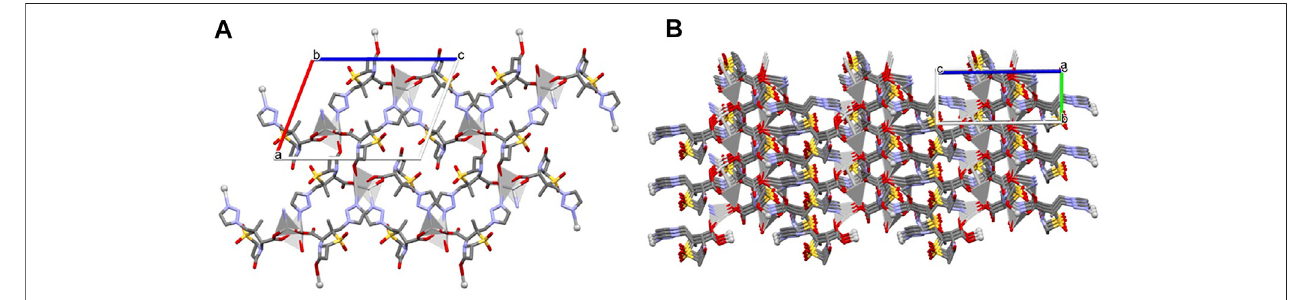
FIGURE 3 | Crystal packing of [Ag(I)-Tazo], depicting (A) the view along the b axis, and (B) the formation of the 3D metal-organic framework.